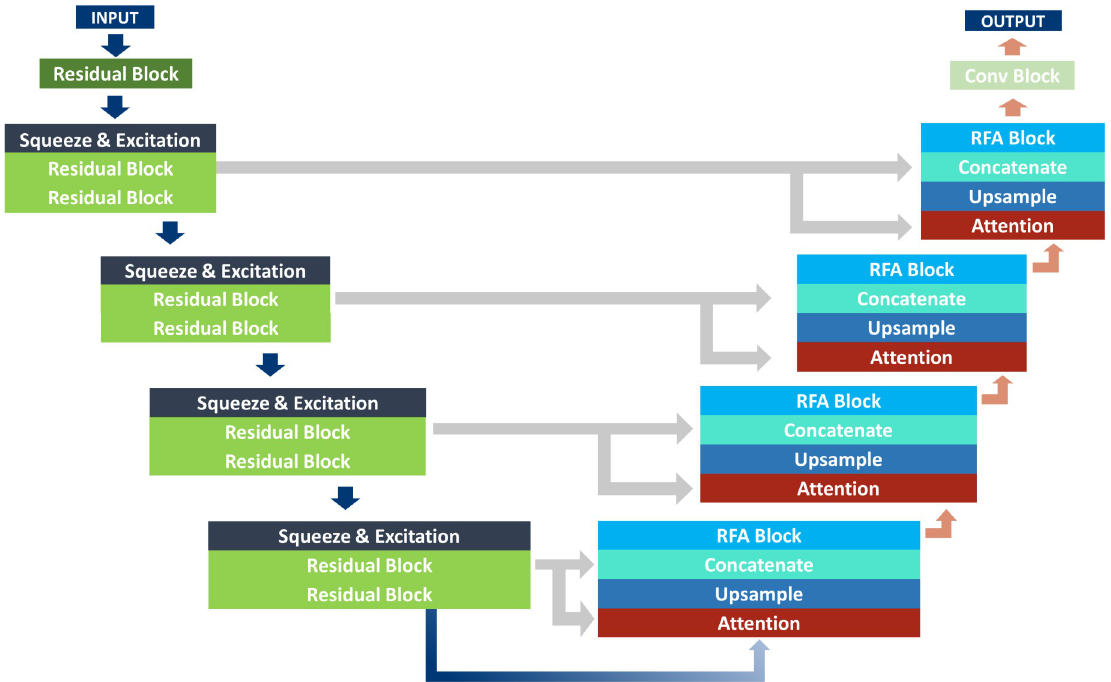
Fig 2. Proposed model architecture. The gray arrow indicates the skip connection that connects the encoder and decoder. The blue arrow indicates the encoding path and the red arrow indicates the decoding path. LV, left ventricle; TEE, transesophageal echocardiography.